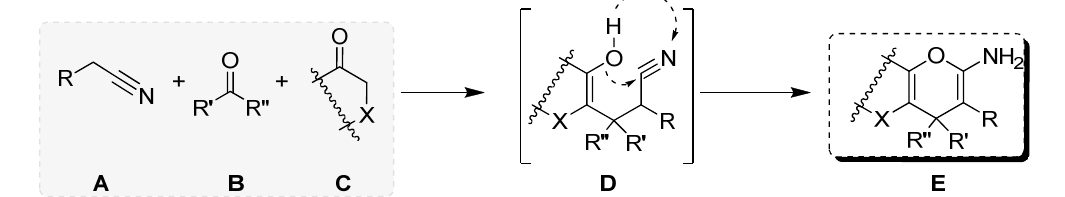
Fig. 1. The general route towards 2-amino-4 H -pyrans